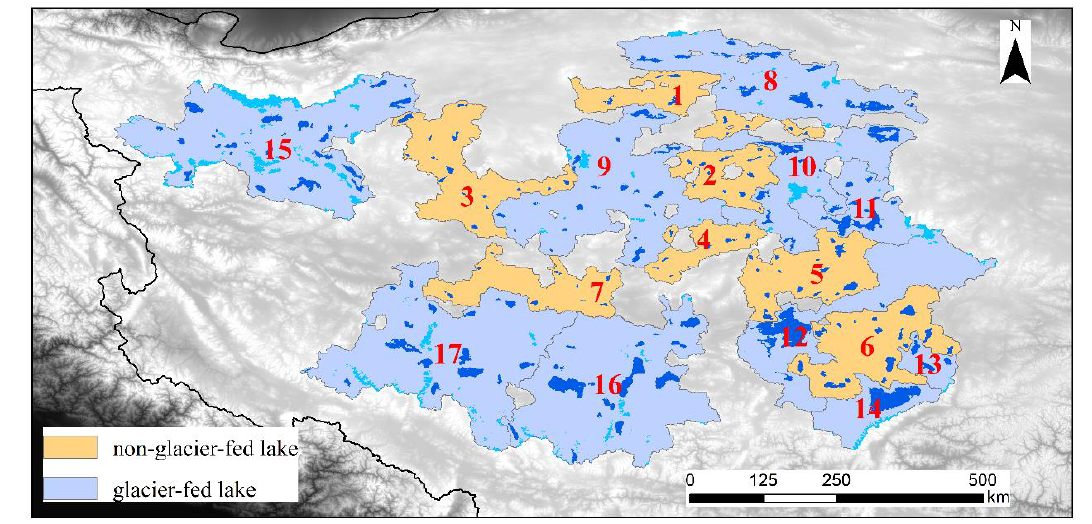
Figure 9. Distribution of lakes and regions on the TP. Regions of 1-7 represent non-glacier-fed lakes basins, regions of 8-17 represent glacier-fed lakes basins.